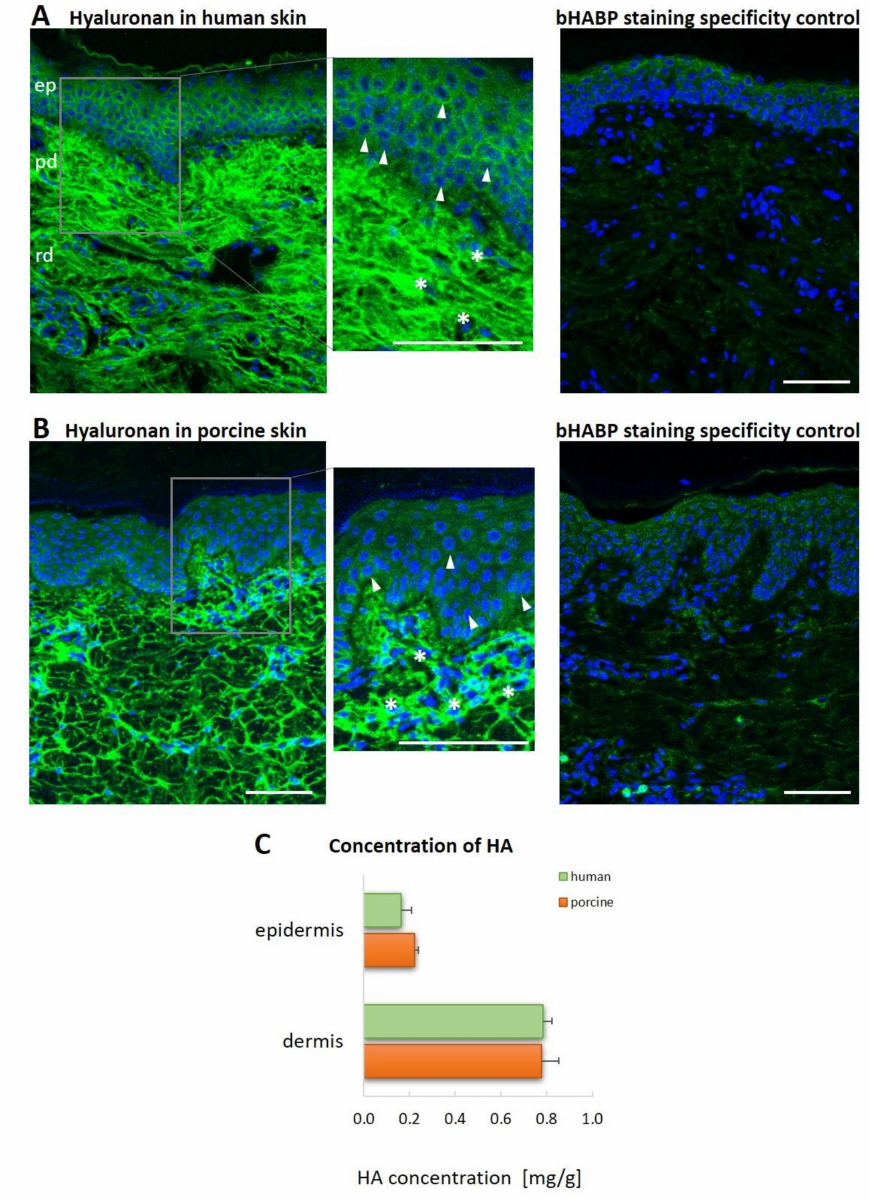
Figure 1. Patterns of hyaluronan staining and the staining concentration in healthy human and porcine skin. ( A , B ) The histofluorescent staining of HA (green) with bHABP in normal ( A ) human and ( B ) porcine skin tissues, fixed and paraffin embedded. Hyaluronidase from Streptomyces hyalurolyticus was used as the control for the bHABP staining specificity. The localization of HA was visualized using a streptavidin-conjugated Alexa 647 and a confocal microscope. The image represents the maximum projection of the z-stack sections. The insets show enlarged views of the regions in the gray boxes. The nuclei were stained with Höechst (blue). The asterisks indicate fibroblasts, and the arrows indicate keratinocytes. The scale bar at the bottom of the figure represents 100 µ m. n = 3 independent experiments. Abbreviations: biotinylated hyaluronan binding protein (bHABP), epidermis (ep), papillary dermis (pd), reticular dermis (rd). ( C ) Quantification of HA in the human and porcine skin. HA content in 100 µ L of lysate from the epidermis and dermis was quantified via LC-MS/MS; the results were then adjusted for the initial tissue weight. The results are presented in units of mg/g of skin tissue. The gray bars represent the means of n = 3 independent biological replicates with